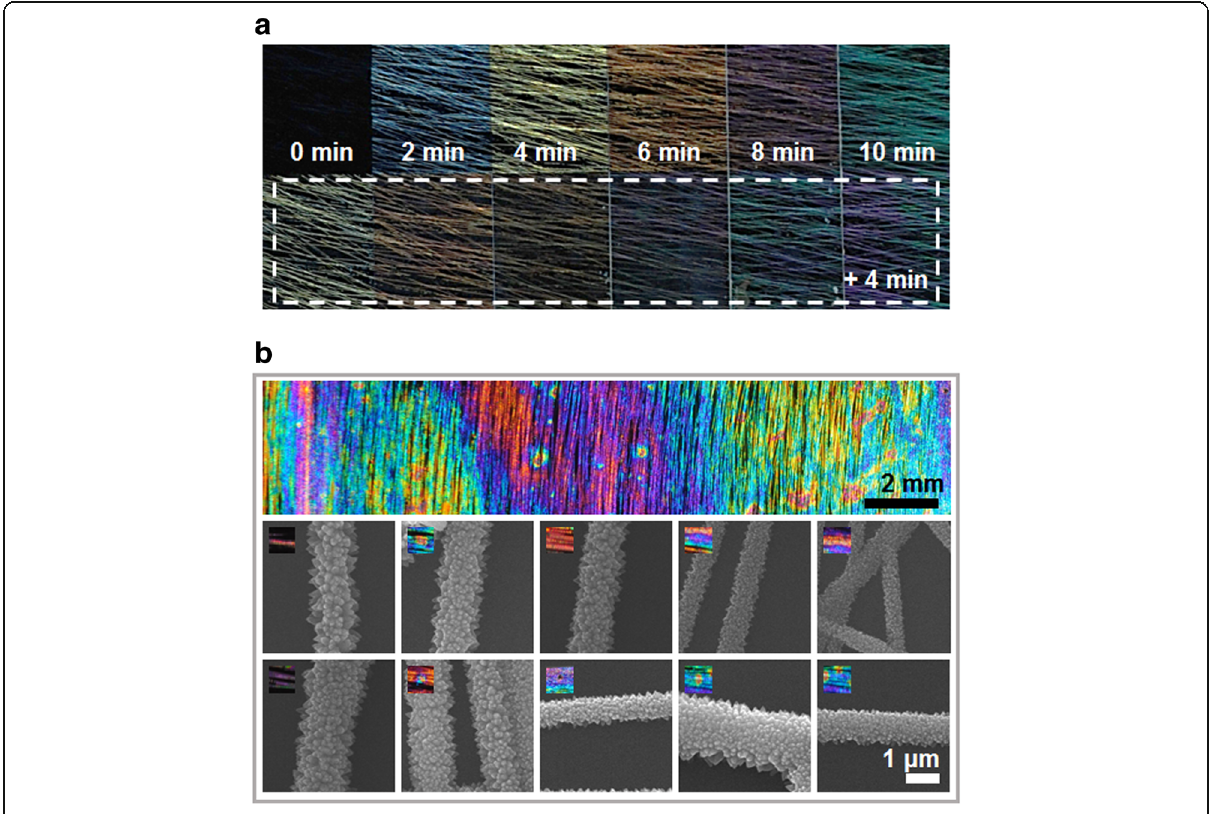
Fig. 2 a Change of structural color as a function of synthesis time. b Optical and scanning electron microscopy images of the nanofibers showing the beautiful structural color pattern attainable with nanofibers fabricated after randomized synthesis